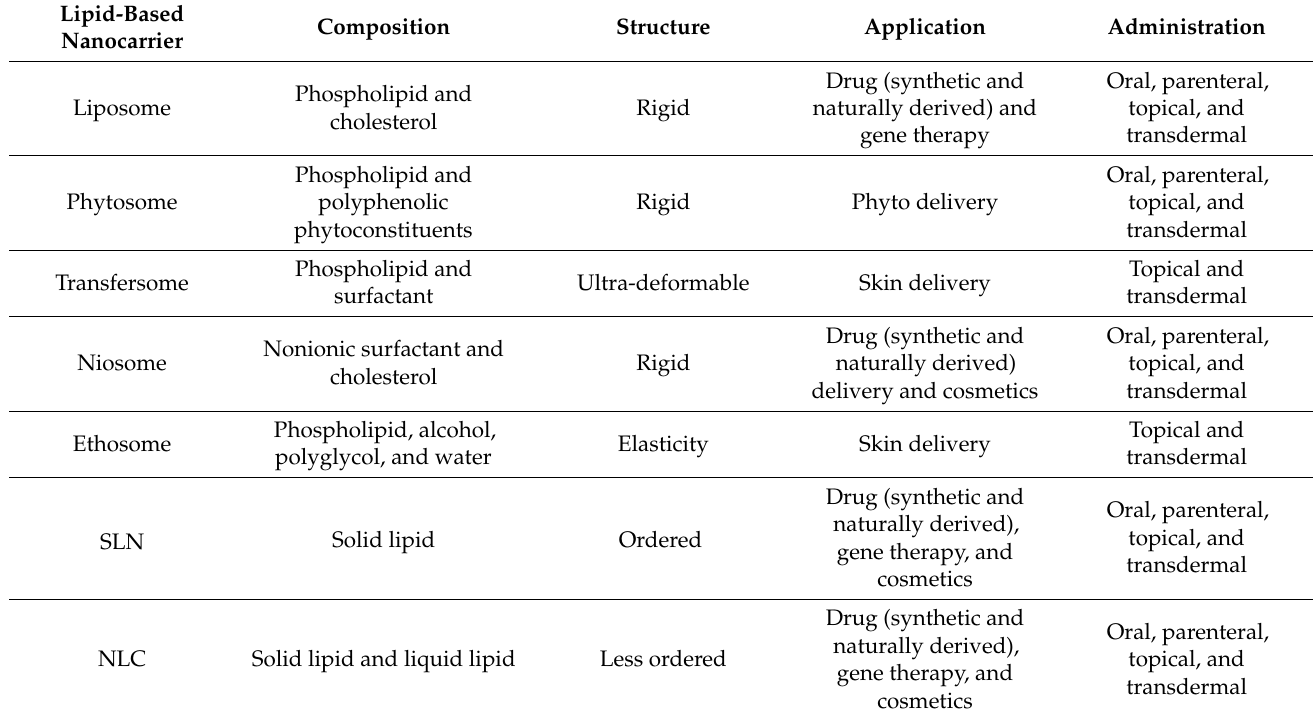
Table 1. Comparative of Lipid-based Nanocarrier